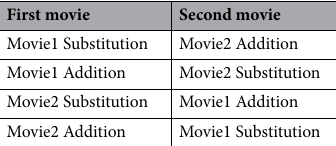
Table 1. Counterbalanced exposure to movies and conditions on